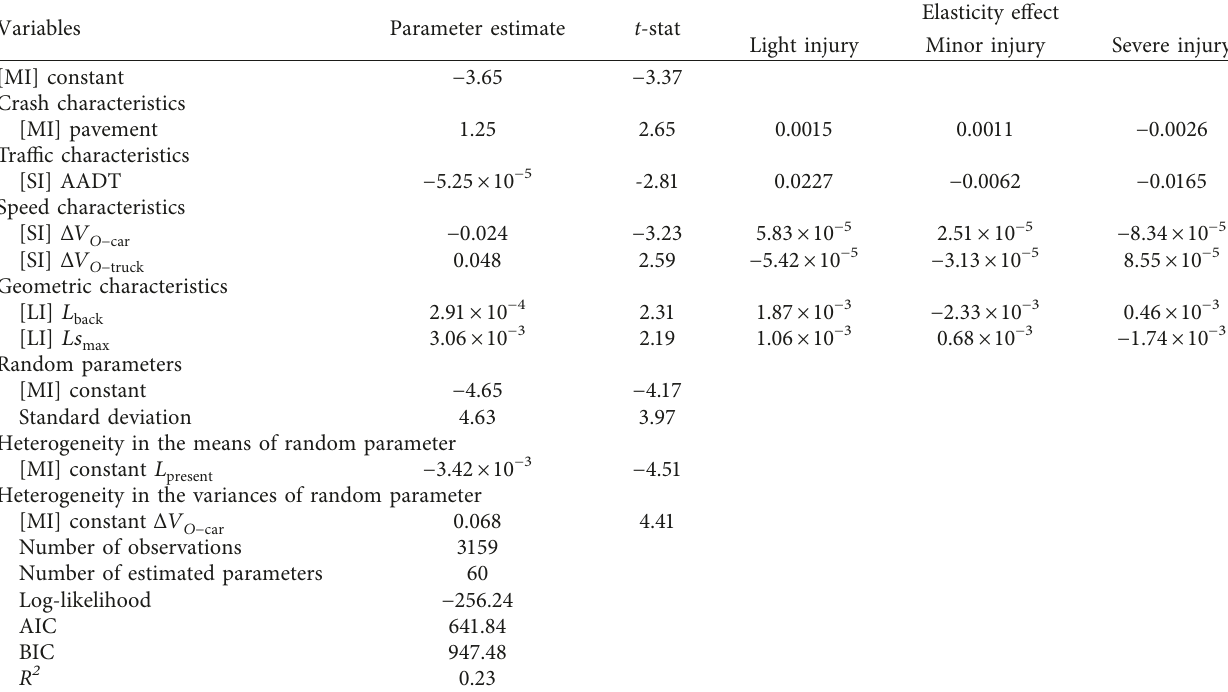
Table 5: Model results of the random parameter logit model with heterogeneity in means and variance for all crashes. Variables